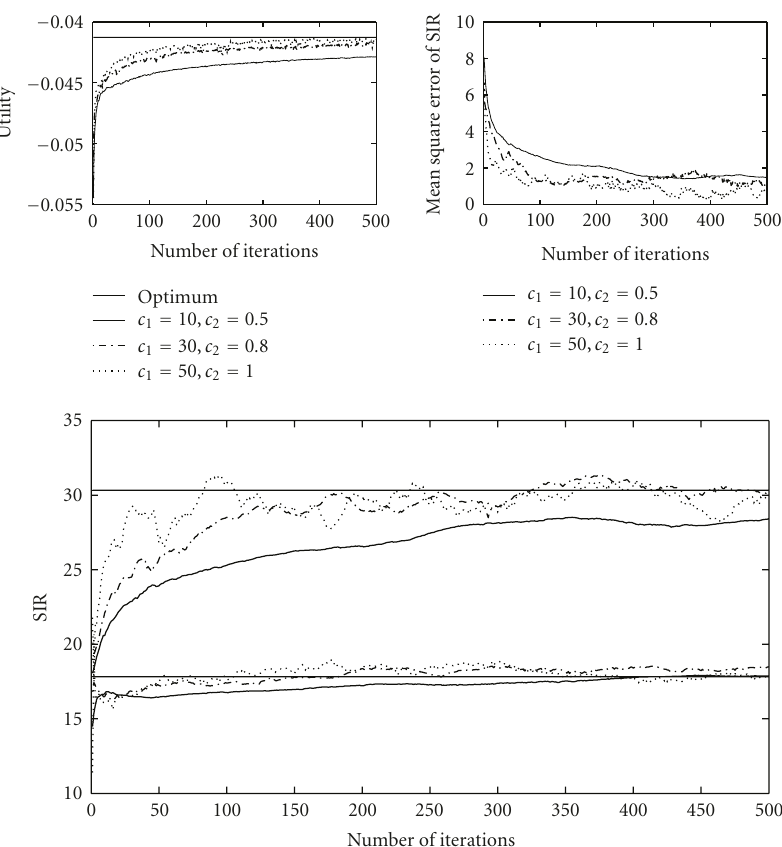
Figure 2: Convergence behavior of the distributed algorithm in case of noisy measurements for di ff erent values of the step sizes c 1 , c 2 and y = 0 .